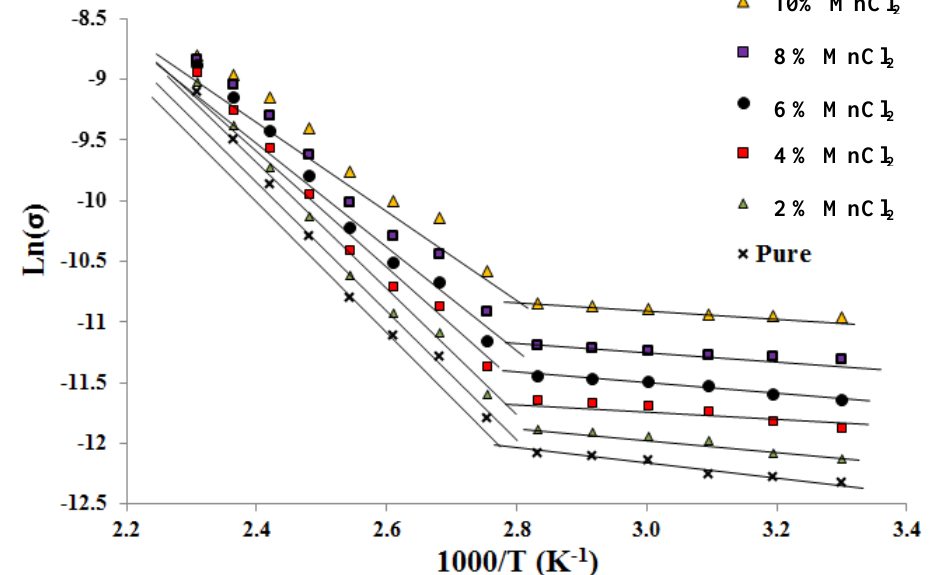
Fig. 2(B): The relation between ln(σ) and the inverse absolute temperature for (PVA:PEG/MnCl ) 2